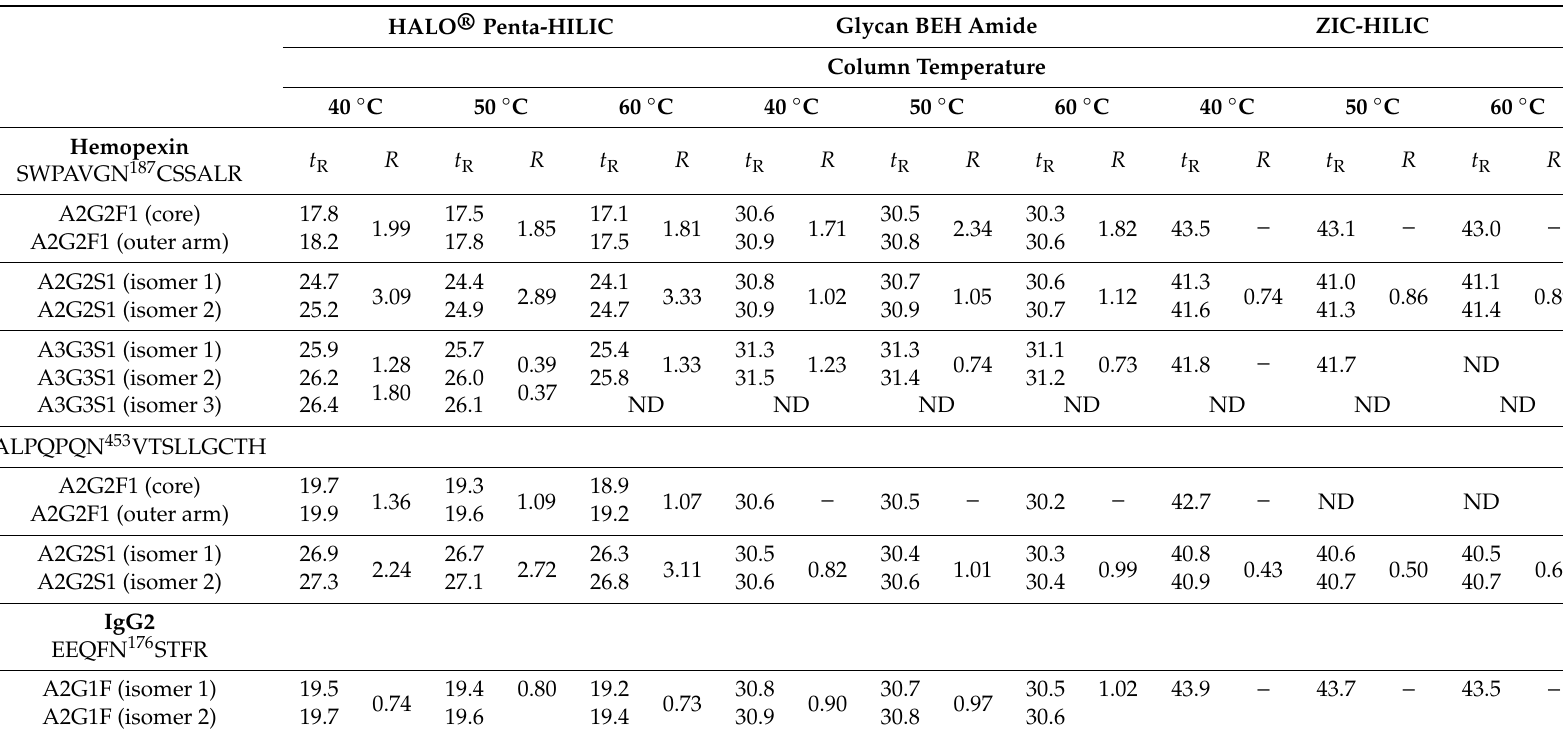
Table 2. Chromatographic parameters: t R , retention time; R , resolution of the HILIC separation of glycopeptide isomers of hemopexin and IgG. ND means not detected